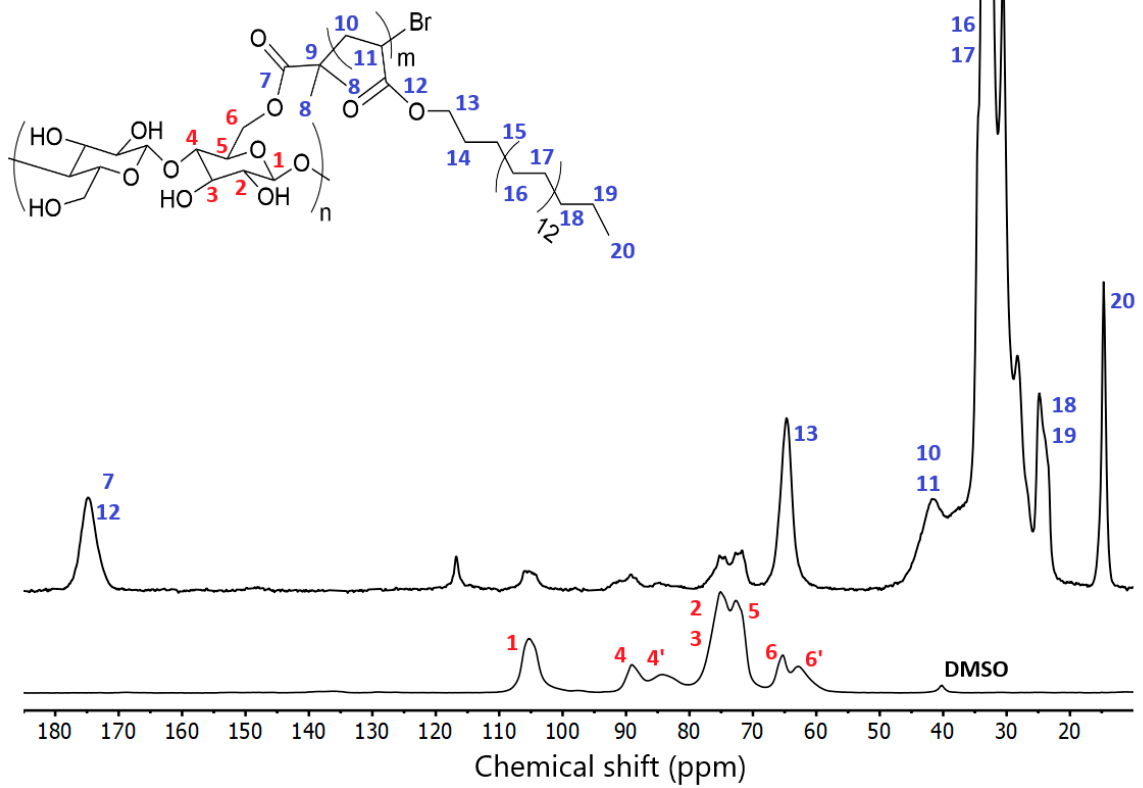
Figure 2. CP/MAS 13 C-NMR spectra of unmodified CNF on the lower part and CNF-PSA on the upper part. upper